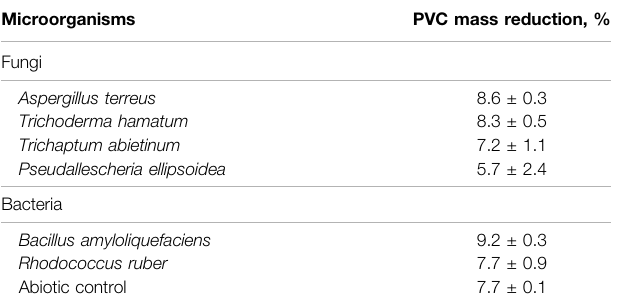
TABLE 3 | Mass-reduction of PVC fi lm by new isolated strains under SSF conditions after 60 days at 28 ° C. Microorganisms